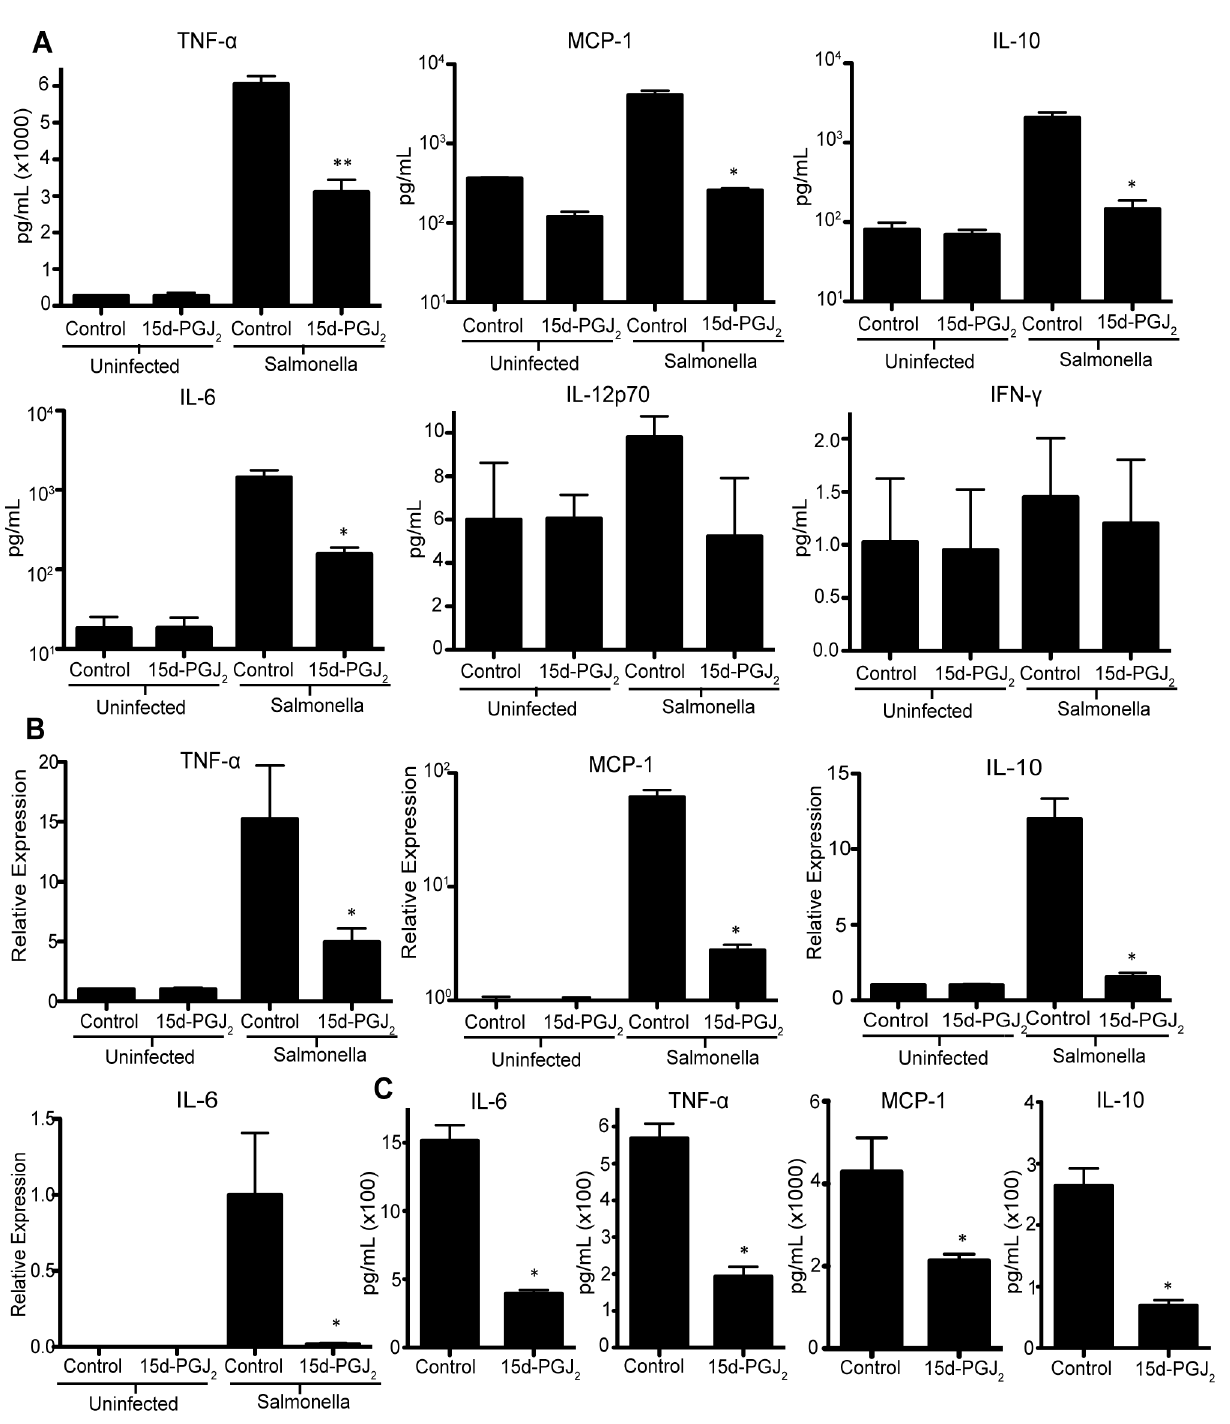
Figure 4. The effect of 2 m M 15d-PGJ 2 treatment during Salmonella infection on cytokine production. RAW264.7 macrophages were examined at 24 hours post infection, cytokine production was determined by; ( A ) CBA assay, ( B ) quantitative real-time PCR, and ( C ) ELISA performed on supernatants from infected cells. Averages of 8 measurements are shown with standard errors of means. (*p , 0.05, **p , 0.001).